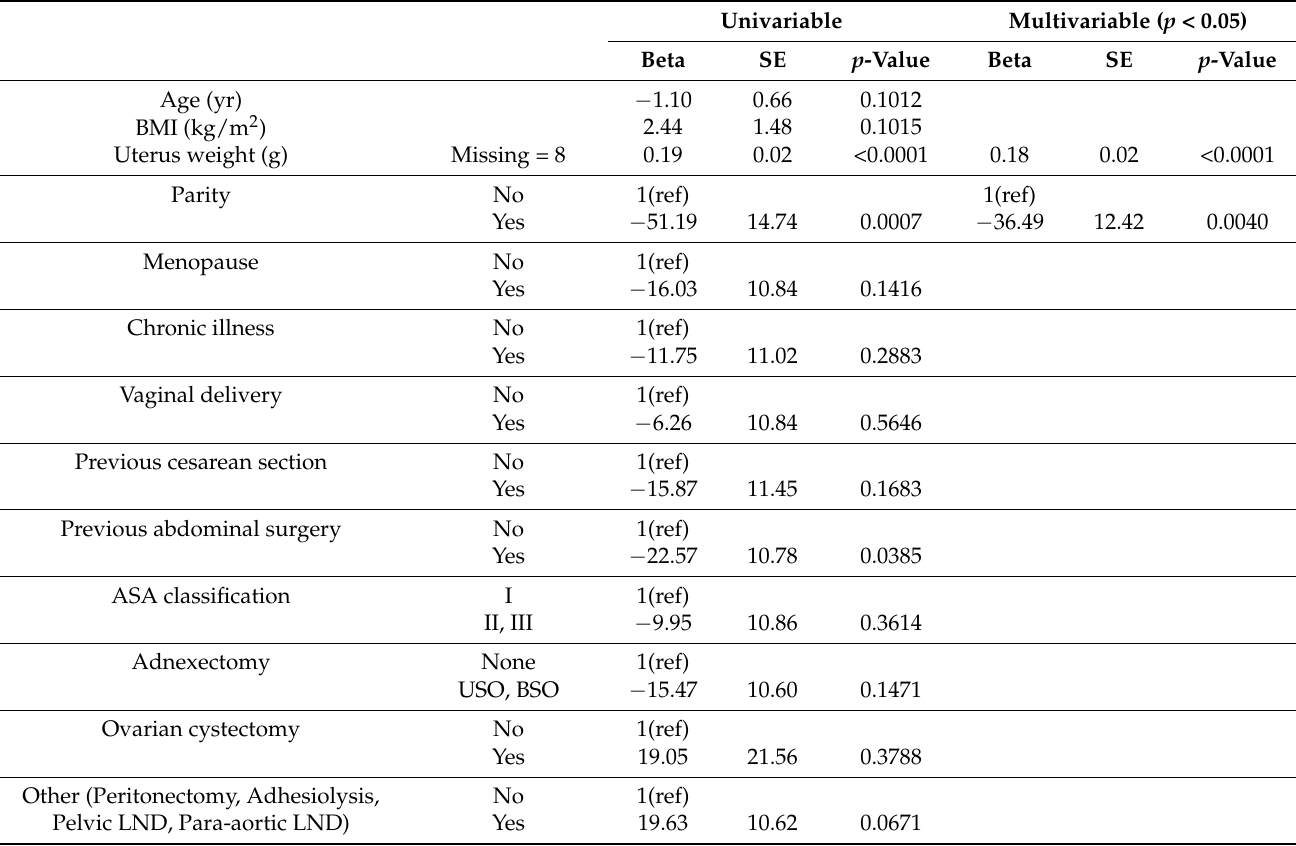
Table 3. Identification of factors affecting operation time using a linear regression